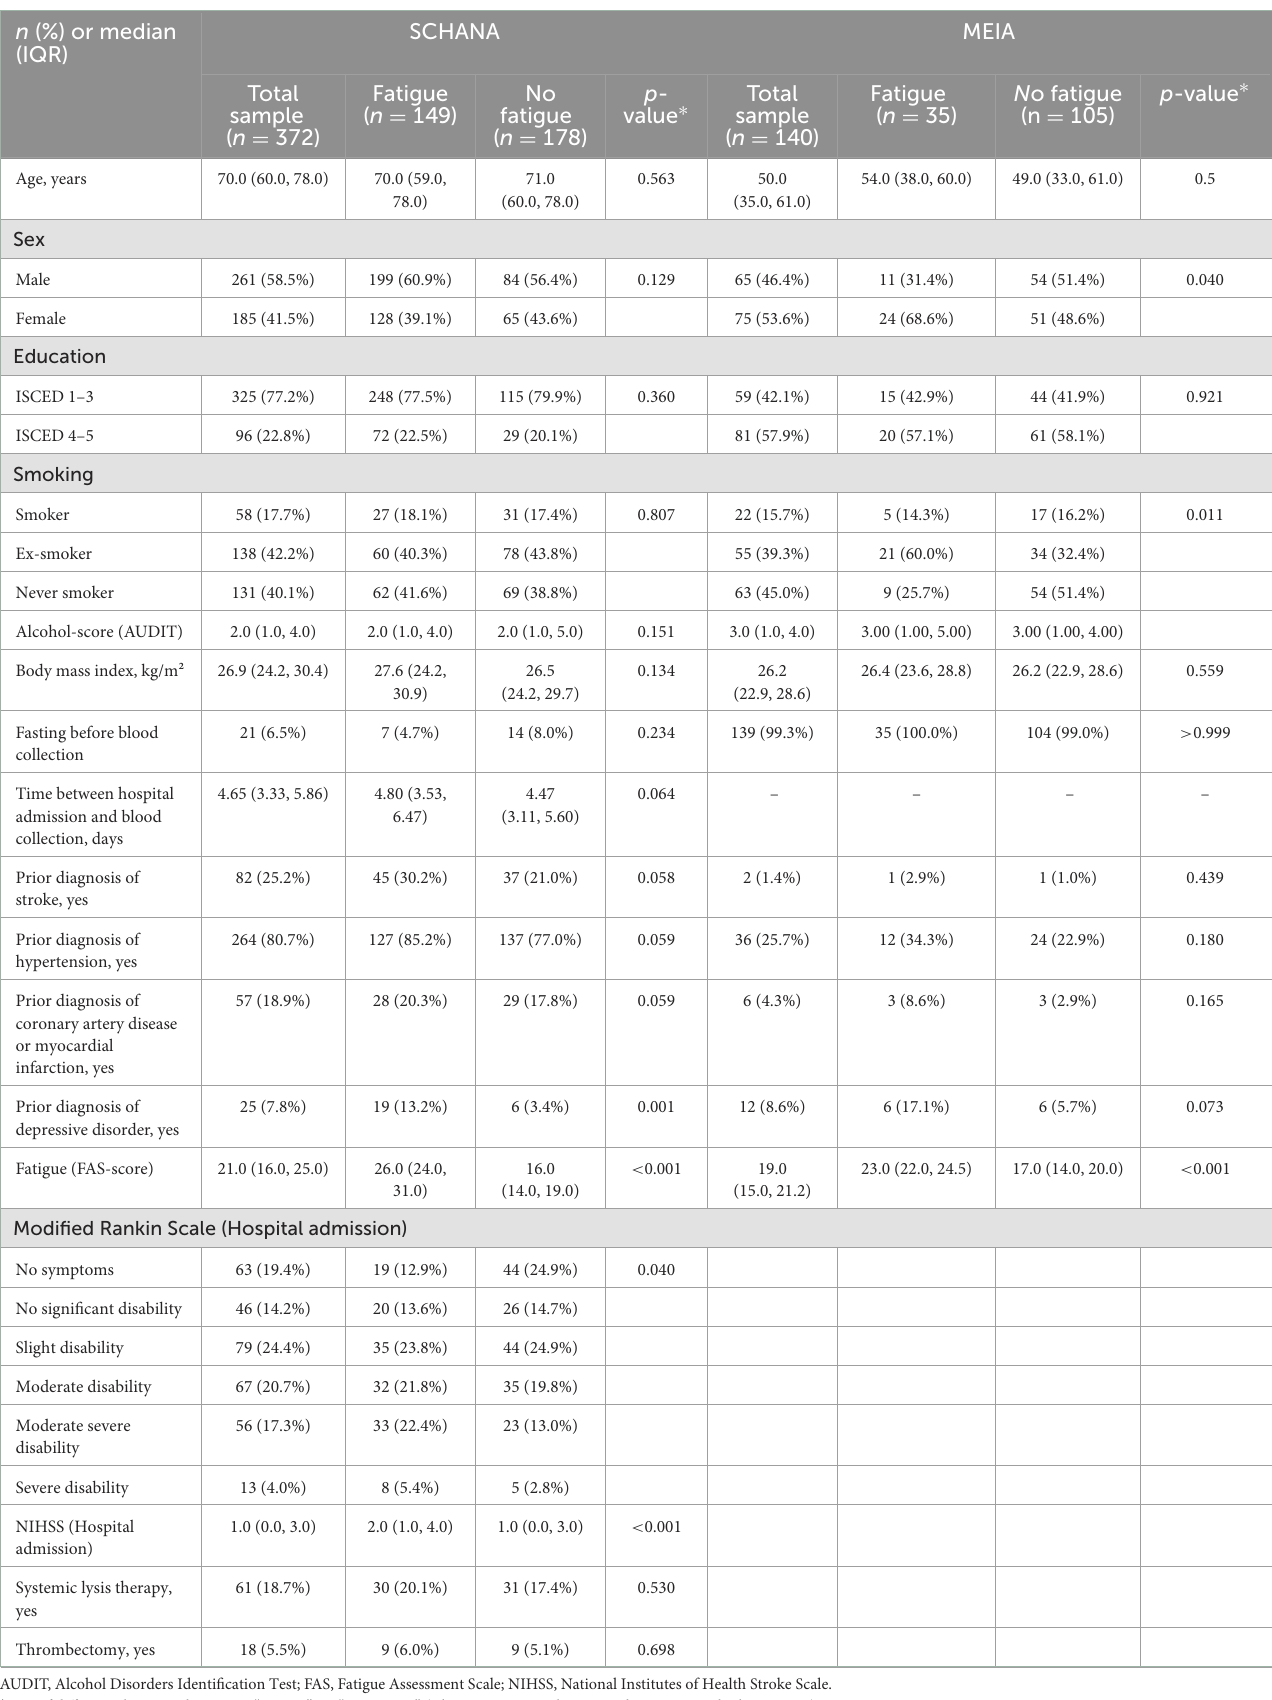
TABLE 1 Characteristics of the “Stroke Cohort Augsburg” (SCHANA) and the “Metabolism, Nutrition and Immune System in Augsburg” (MEIA)